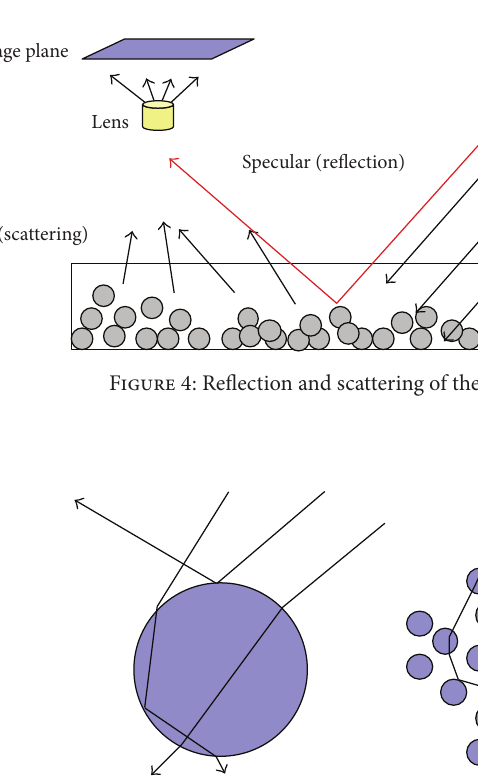
Figure 5: Complexity of refraction/reflection of